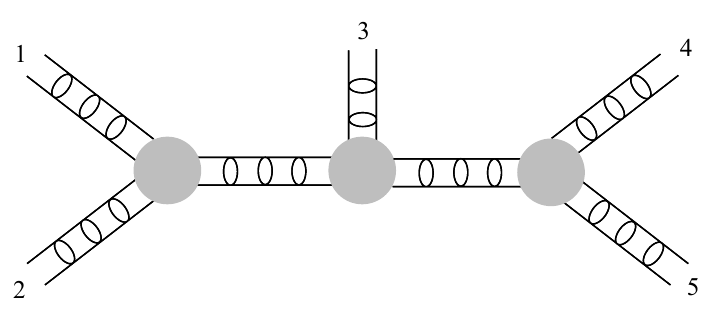
Figure 13. A contribution to the ten-point